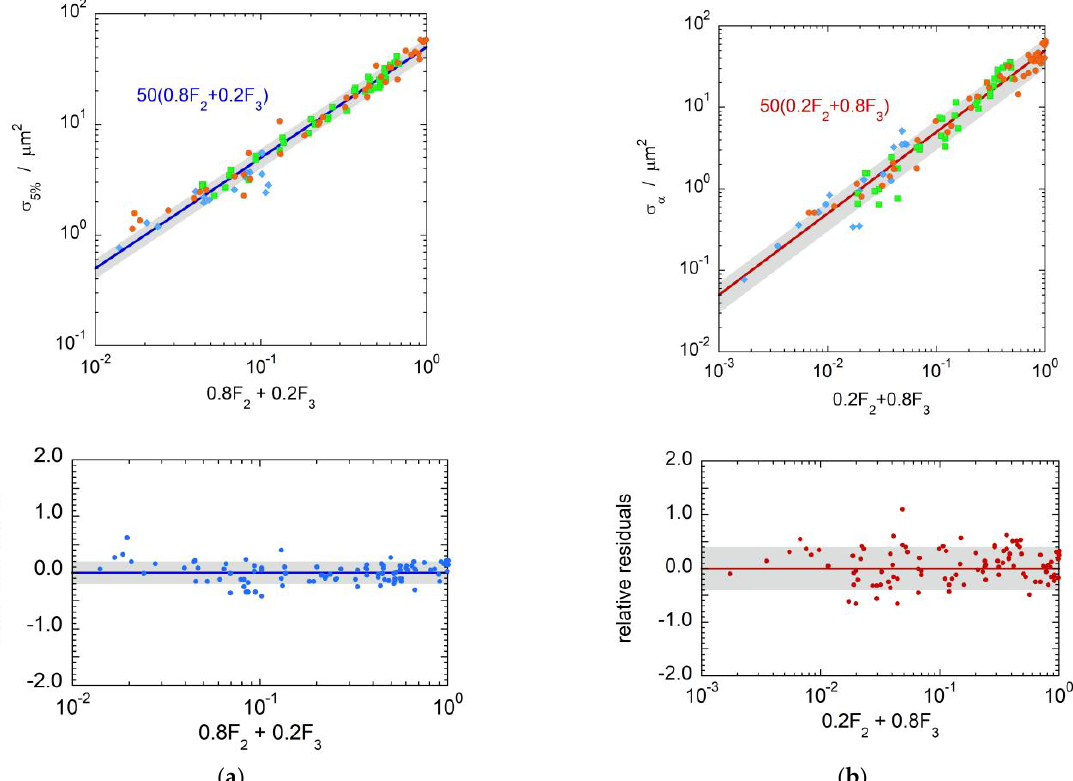
Figure 5. ( a ) Biological inactivation cross sections at 5% survival, σ 5% , for asynchronous V 79 cells irradiated by protons (diamonds), helium (squares) and carbon ions (circles) as a function of the cumulative probabilities [ 0.8 F 2 ( Q ) + 0.2 F 3 ( Q )] in target volumes of diameter 1 nm. The bottom panel shows the relative residuals with respect to the function 50 ( 0.8 F 2 + 0.2 F 3 ) . ( b ) Biological inactivation cross sections at high survival, σ α , for asynchronous V79 cells irradiated by protons, helium and carbon ions as a function of the cumulative probabilities [ 0.2 F 2 ( Q ) + 0.8 F 3 ( Q )] in a target volume of diameter 1 nm. The bottom panels ( a , b ) show the relative residuals of σ 5% and σ α with respect to the functions 50 [ 0.8 F 2 + 0.2 F 3 ] and 50 [ 0.2 F 2 + 0.8 F 3 ] , respectively.